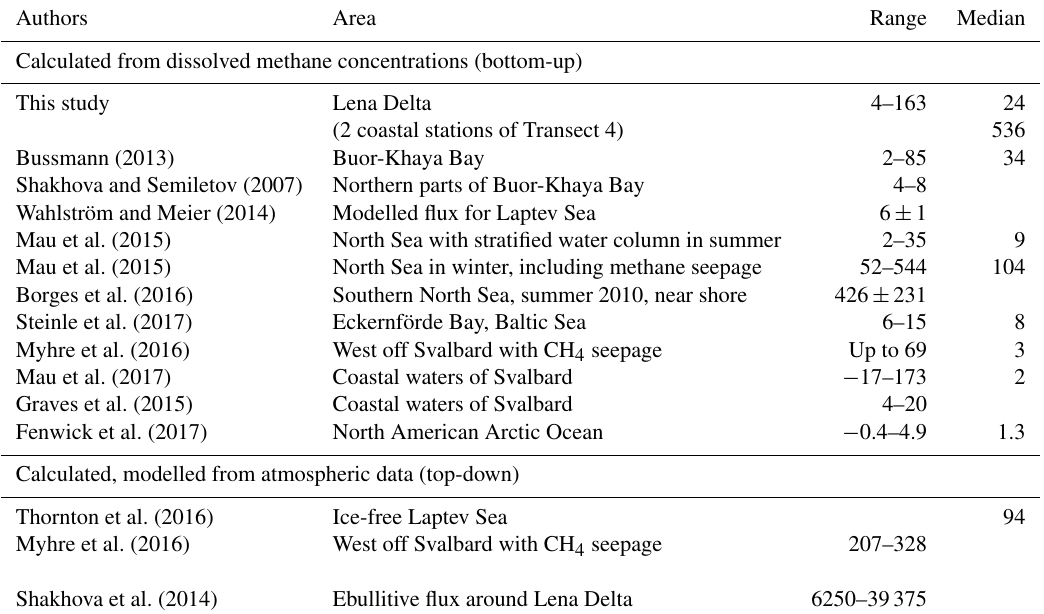
Table 5. Comparison of diffusive methane flux from the water column into the atmosphere of this region and temperate and polar shelf seas (inµmolm 2 d − 1 ).